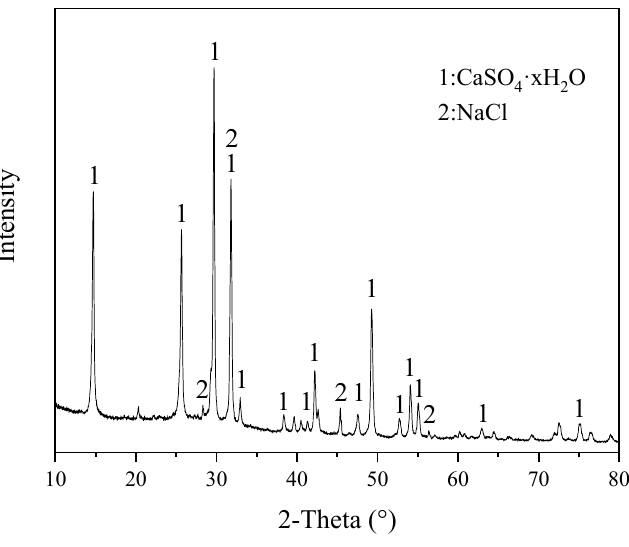
Figure 7. XRD diagram of precipitation. Table 3. The concentration of alkali metals, chlorine, and heavy metals under different washing